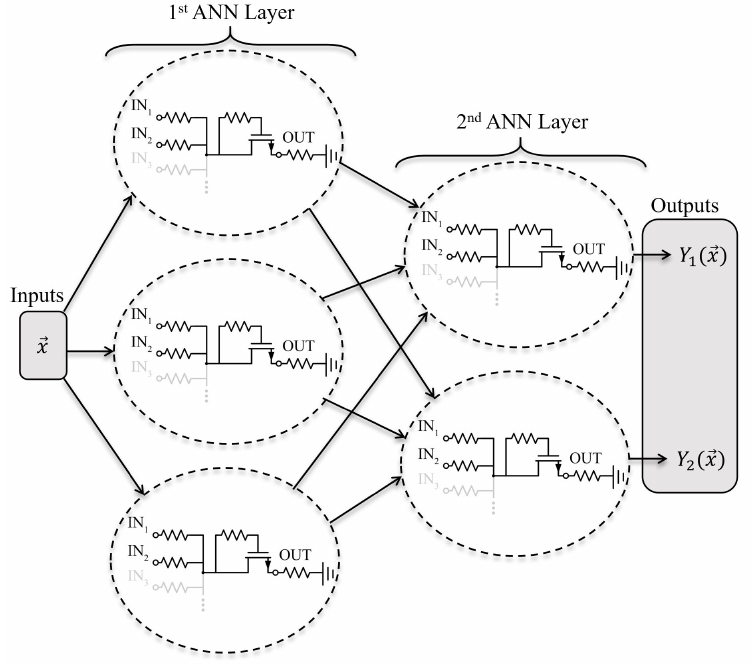
Figure 1. Topology of printed ANN with the proposed neuron design, two layers, and a topology of 3 ×